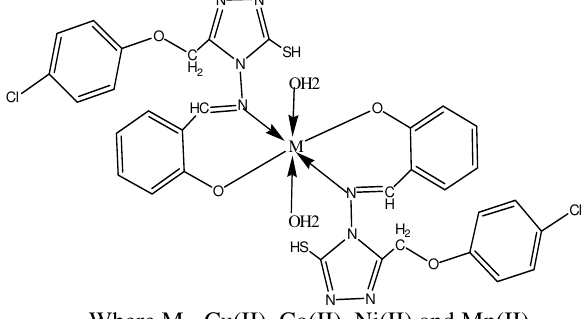
Figure 2. Probable structure of complexes of the ligand